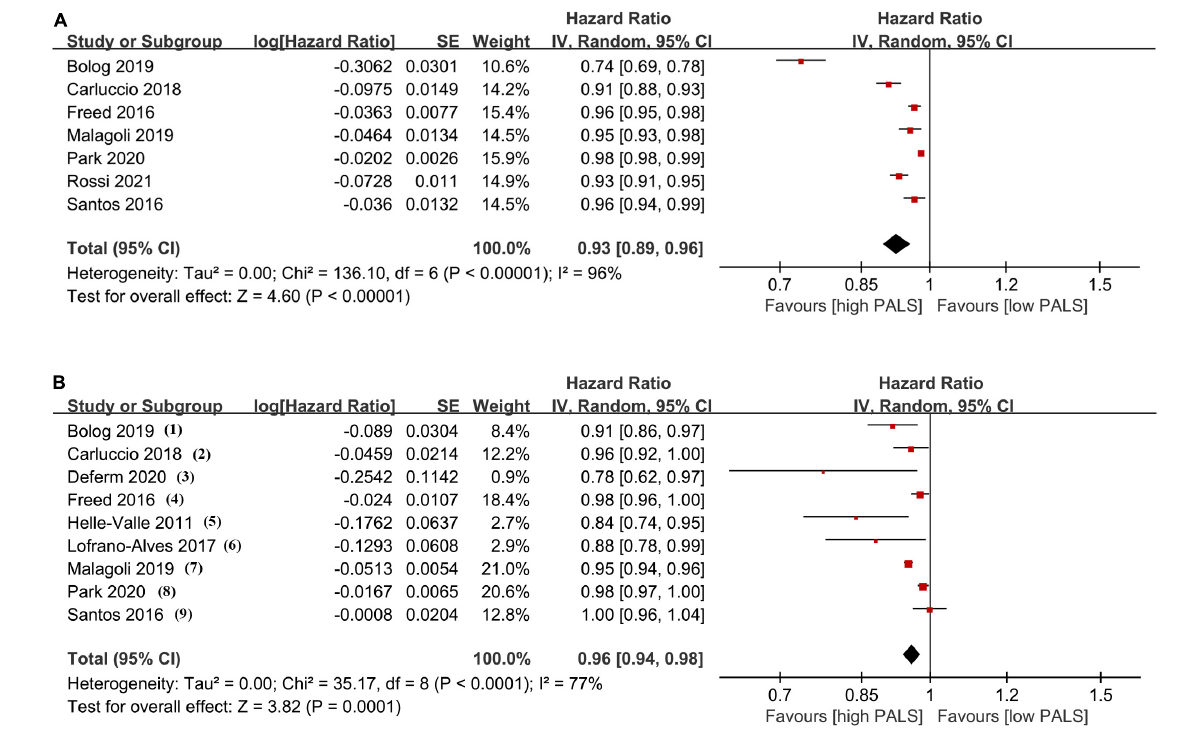
FIGURE 3 | The pooled hazard ratio (HR) of peak atrial longitudinal strain (PALS; per 1-unit increase) in univariate analysis (A) and multivariate analysis (B) for predicting endpoint. Covariates in multivariate analysis: (1) age, hypertension, diabetes, left atrial volume index (LAVI), left ventricular global longitudinal strain (LVGLS); (2) eplerenone in mild patients hospitalization and survival study in heart failure (EMPHASIS-HF) risk score, New York Heart Association (NYHA) class, log(BNP), implanted cardioverter defibrillator (ICD) at baseline, cardiac resynchronization therapy (CRT) implant during follow-up, LAVI, end-diastolic volume index (EDVI), left ventricular ejection fraction (LVEF), E/e’, mitral regurgitation severity, LVGLS; (3) LAVI, left ventricular end-diastolic volume (LVEDV), and LVGLS; (4) sex, atrial fibrillation (AF), meta-analysis global group in chronic heart failure (MAGGIC) risk score, LV mass, LAV, E/e’, LVGLS, RV free wall strain; (5) age, N-terminal pro-brain natriuretic peptide (NTproBNP), LA area, LVEF, E/e’; (6) LVEF, LVGLS, right ventricular global longitudinal strain (RVGLS); (7) age, NYHA class, glomerular filtration rate (GFR), brain natriuretic peptide (BNP), left ventricular end-systolic volume index (LVESVi), LVEF, LAVI, E/A, and E/e’; (8) age, sex, BMI, NYHA IV, diastolic blood pressure (DBP), heart rate, hypertension, diabetes, AF, ischemic heart disease (IHD), hemoglobin, creatinine, total cholesterol, LVEF, log(NTproBNP), and LAVI; (9) age, sex, race, randomization strata, enrollment region, randomized treatment assignment, AF, heart rate, NYHA, stroke, creatinine, hematocrit, LVEF, LAVI, and